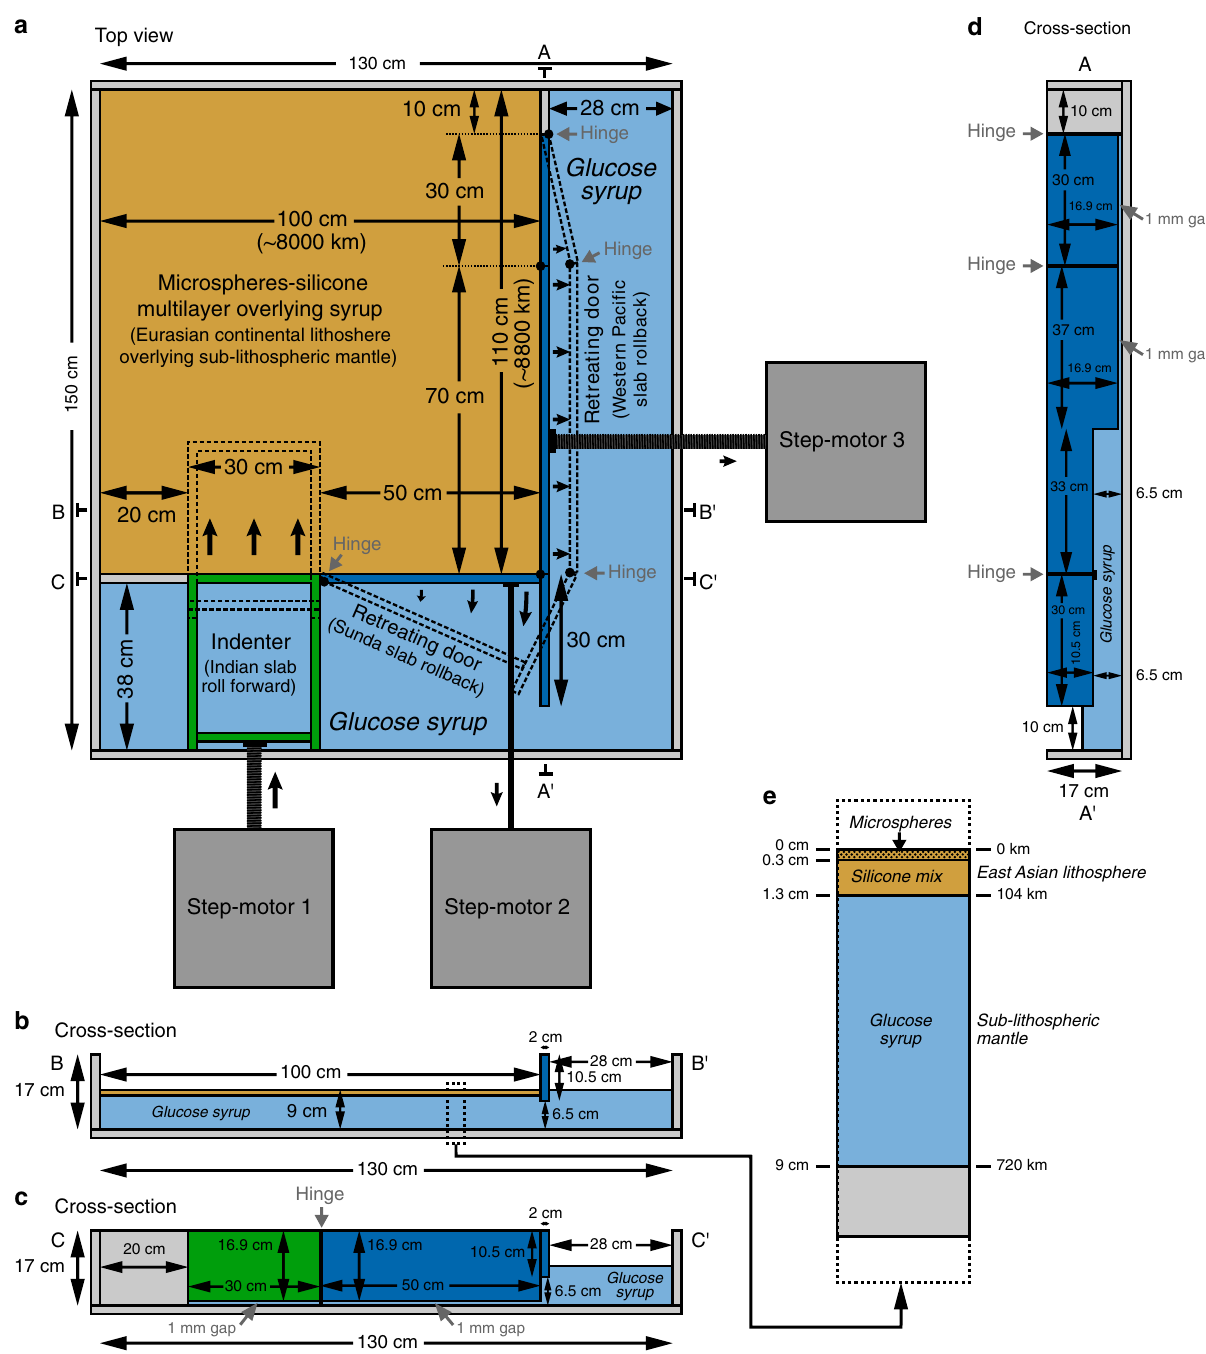
Fig. 2 Schematic diagrams illustrating the experimental apparatus set-up. The experiments investigate widespread deformation of a layered brittle – ductile system simulating part of the Eurasian continental lithosphere. a Top view of the experimental apparatus. Deformation in the model lithosphere is induced by northward motion of a rigid boundary (simulating progressive indentation of India into Eurasia and roll forward of the Indian slab and hinge) and outward motion of two retreating boundaries (simulating eastward slab rollback of the Western Paci fi c subduction margin and southward rollback of the Sunda slab). Motion of the three boundaries is driven by three step-motors. b , c East – west cross-sectional views through the model lithosphere and the southern boundary. d Cross-sectional view through the eastern boundary. e Vertical pro fi le of the model layers with a frictional-plastic top layer made of fi ne-grained glass microspheres to simulate the brittle upper lithosphere, a linear-viscous layer of fi lled silicone oil simulating the ductile lower lithosphere (dynamic shear viscosity of 5.8 ± 0.2 × 10 4 Pa s), and a bottom layer made of low-viscosity glucose syrup with a linear viscous rheology (dynamic shear viscosity of 254 ± 7 Pa s) to simulate the sub-lithospheric mantle. Note that only the inner compartment of the box is fi lled with the layered system (continental lithosphere), while the entire box is fi lled with the low-viscosity bottom layer (sub-lithospheric upper mantle) to isostatically support the model continental lithosphere. Also note that 1 cm in the model represents 80 km in